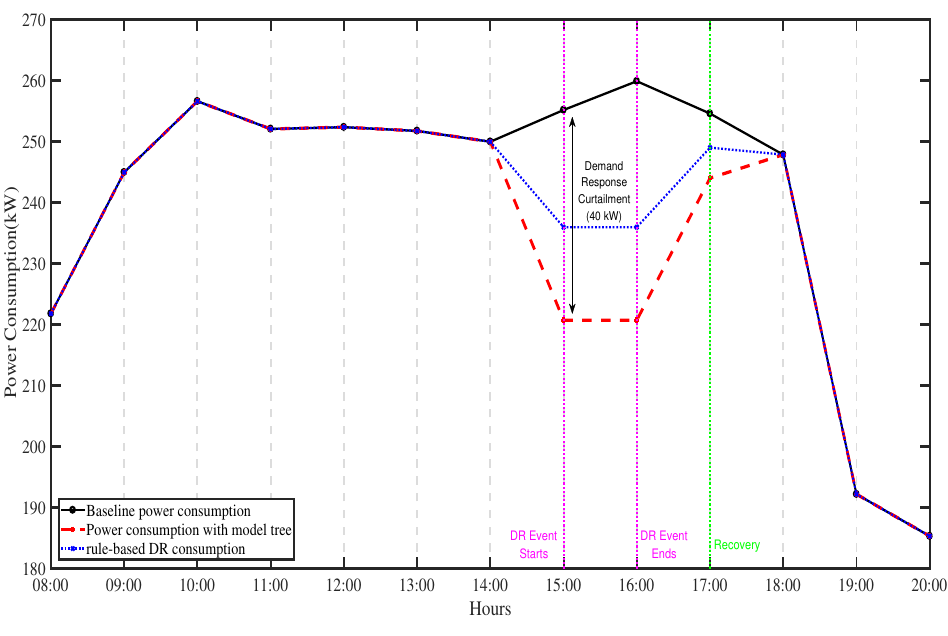
Figure 6. DR synthesis using the MBCRF algorithm for 10 August 2011.